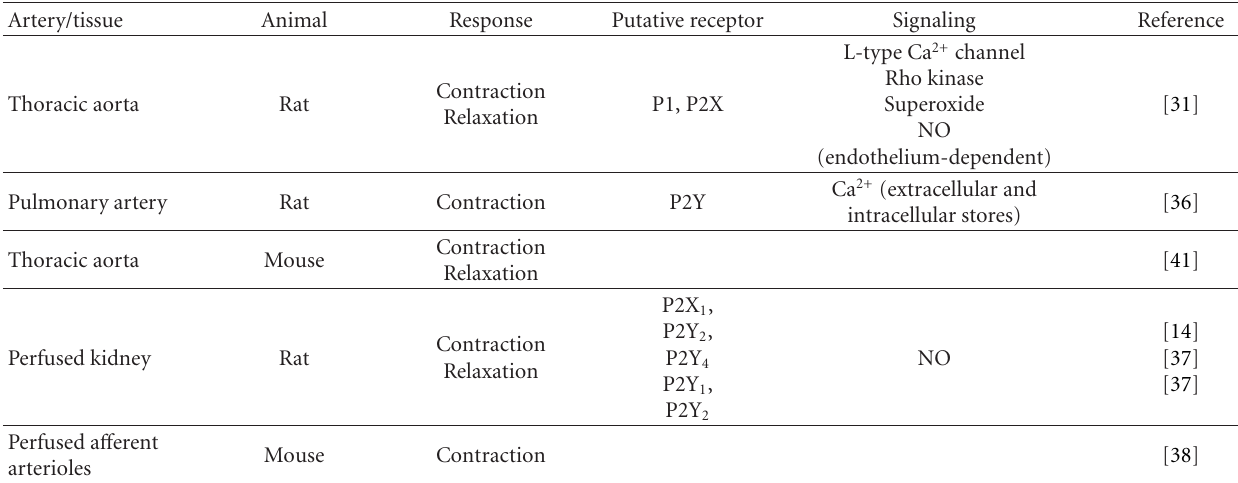
Table 1: Up 4 A and vascular